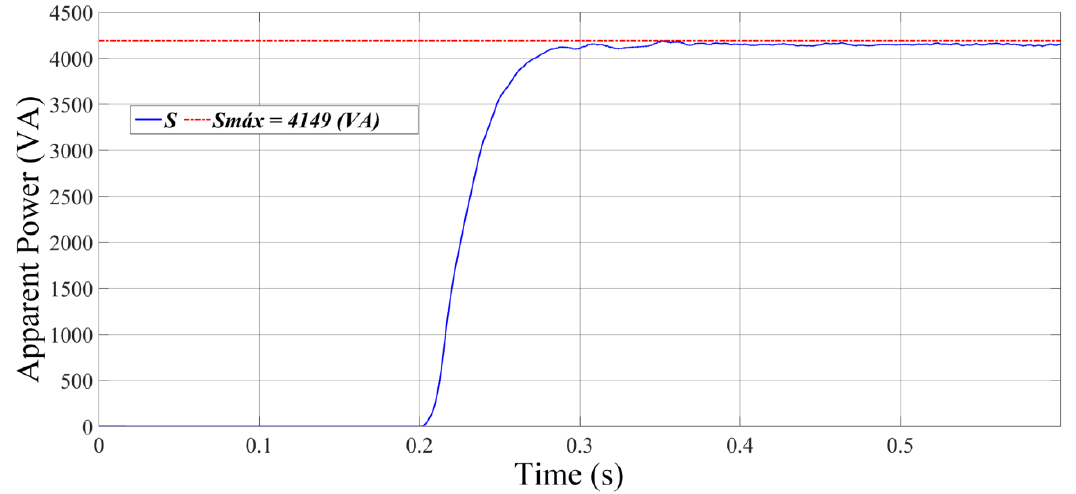
Figure 11. Voltage (upper, 10 kV/div) and current (lower, 5 A/div) imposed to TUT, F p = 0.85 inductive. Horizontal axis: 5 ms/div.